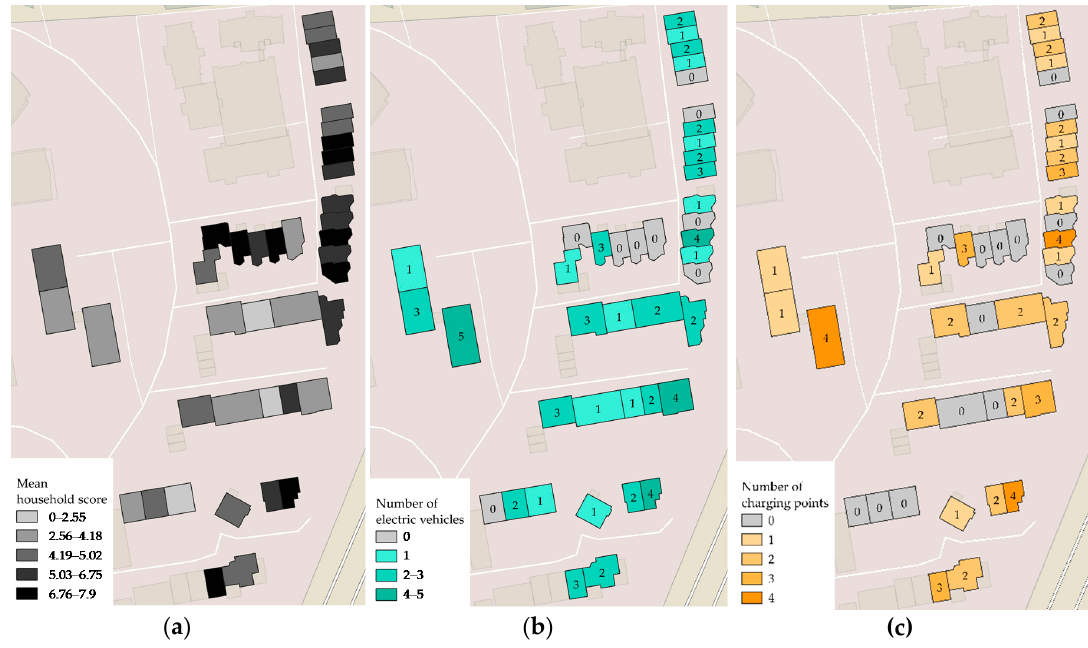
Figure 8. ( a ) Mean household score per building. ( b ) Number of vehicles per building in 1 of 50 variants. ( c ) Number of charging points per building in 1 of 50 variants. Map data copyright OpenStreetMap contributors (www.openstreetmap.org /